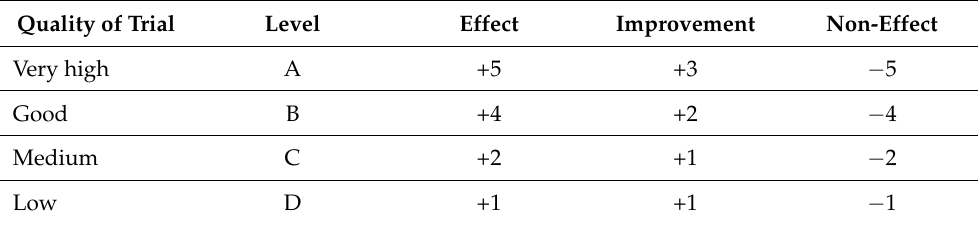
Table 3. Weighing of efficacy scores in function of quality of each